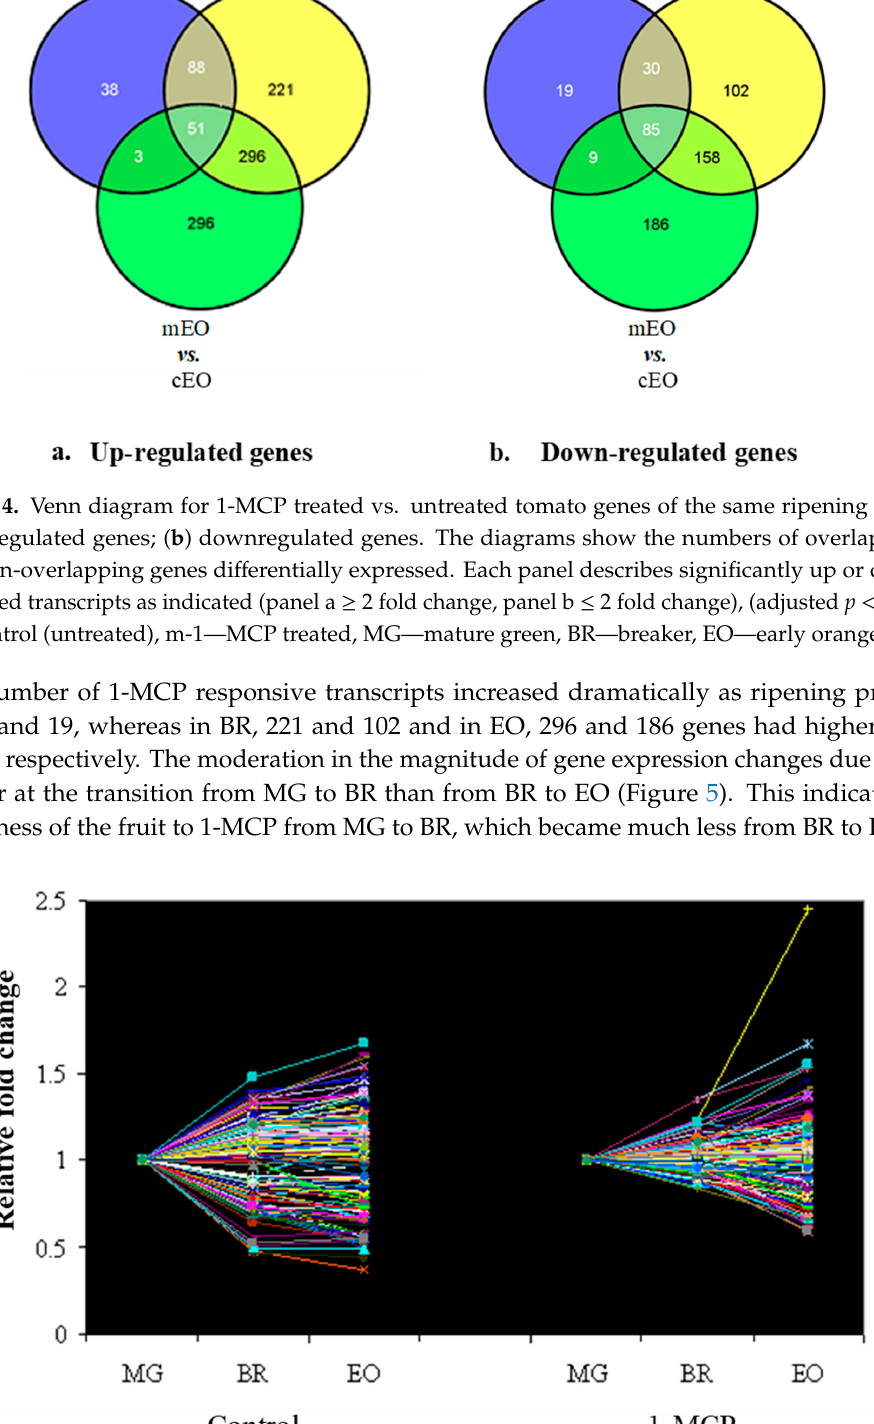
Figure 5. The difference in expression of 1-MCP responsive transcripts common to MG, BR, and EO tomatoes, between sequential ripening stages of 1-MCP treated or untreated tomatoes ( n = 136). The expression of MG ripening stage served as a reference for the other stages in each comparison. MG— mature green, BR—breaker, EO—early orange.